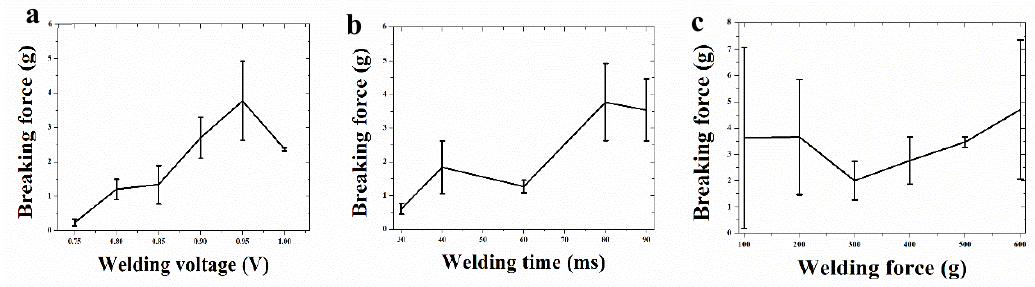
Figure 16. Factors affecting the welding quality: ( a ) welding voltage, ( b ) welding time, and ( c ) welding force.